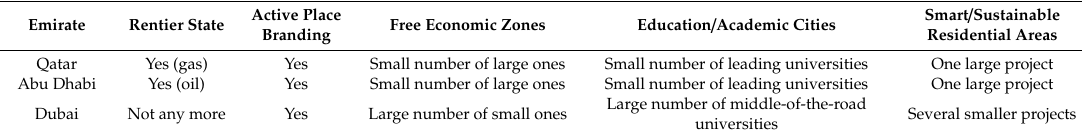
Table 6. Summary table with key